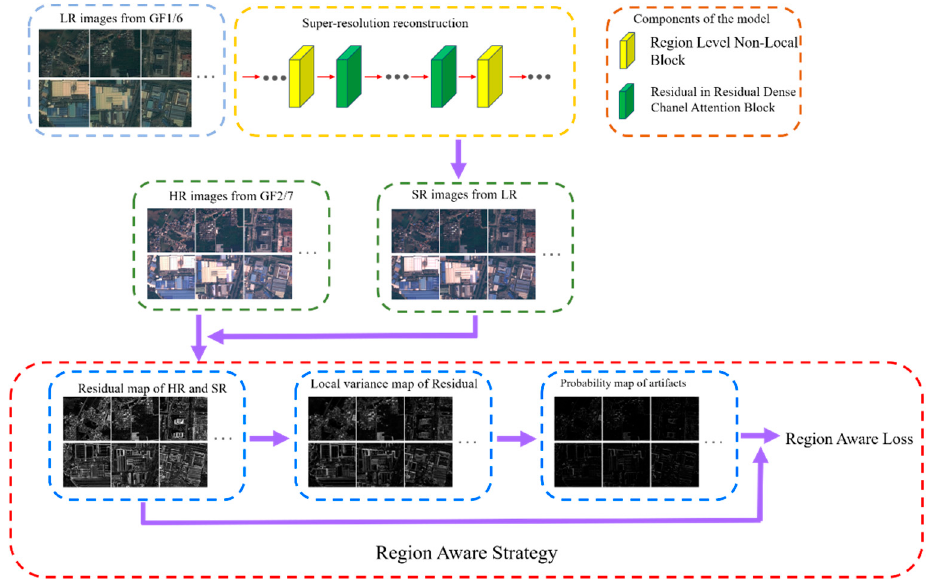
Figure 1. Framework of the method. For the LR input, the reconstruction is performed by a GAN network containing second-order channel attention and region-level non-local blocks; region-aware loss is used to constrain the generation of artifacts.